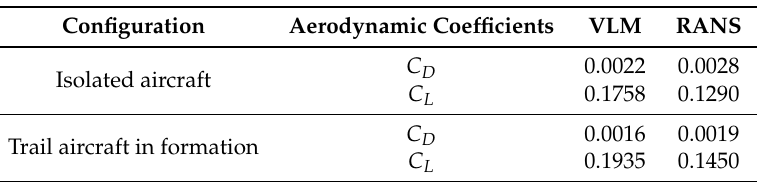
Table 1. Drag and lift coefficients for isolated and trail aircraft in formation for the blended-wing- configuration at optimal